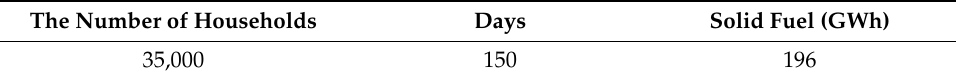
Table 11. Solid fuel consumption (GWh) for 35,000 households depending on the number of observed days for Sarajevo Canton. The Number of Households Days Solid Fuel (GWh) 35,000 150 196